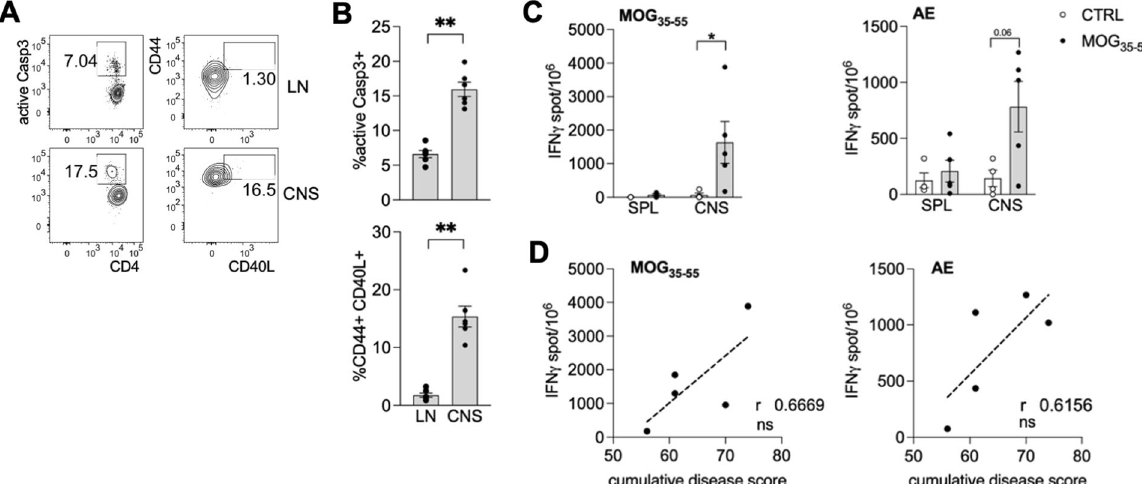
Fig. 1 Apoptotic T cells and AE-speci fi c CD8 + T cells accumulate in the CNS of mice with EAE. A , B C57BL/6 mice ( n = 6) were immunized with 100 µg